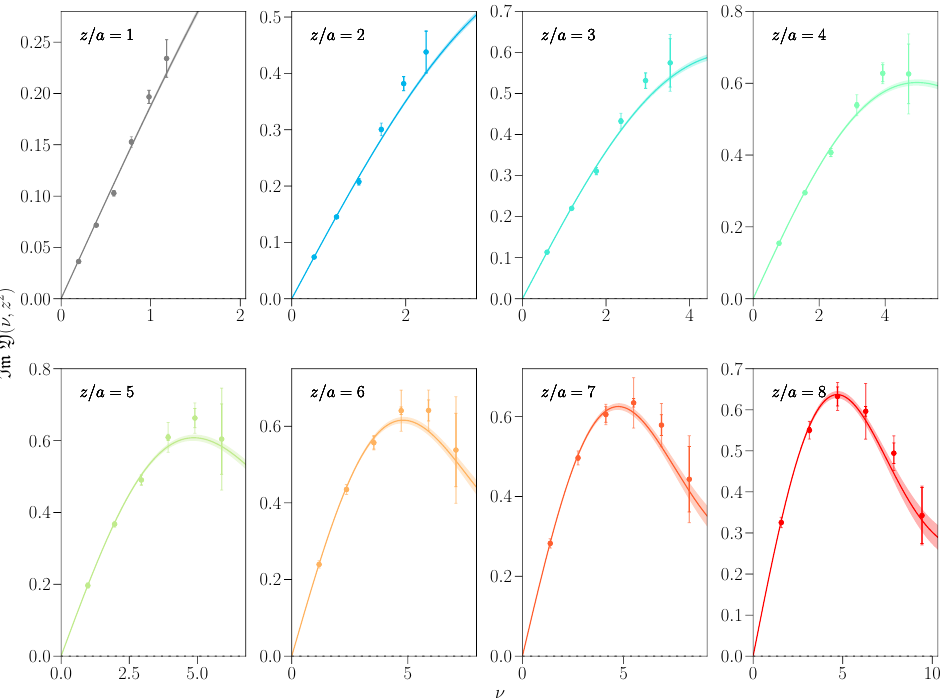
(cid:0) (cid:1) ν, z 2 obtained from